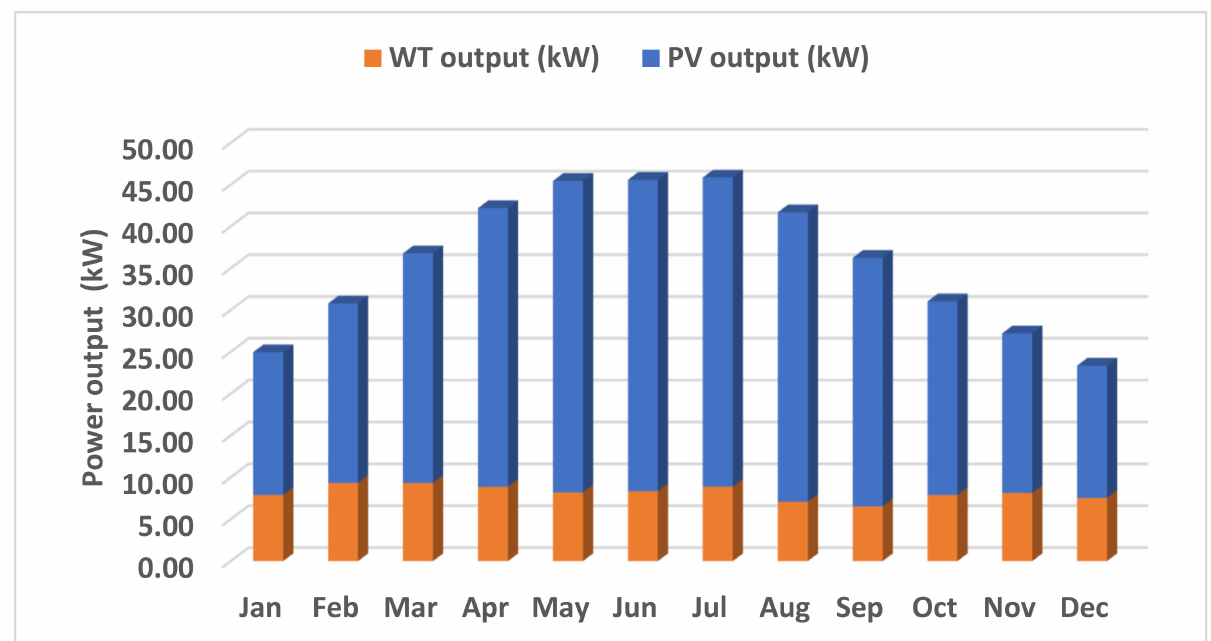
Figure 11. The monthly average energy production from the PV and WT